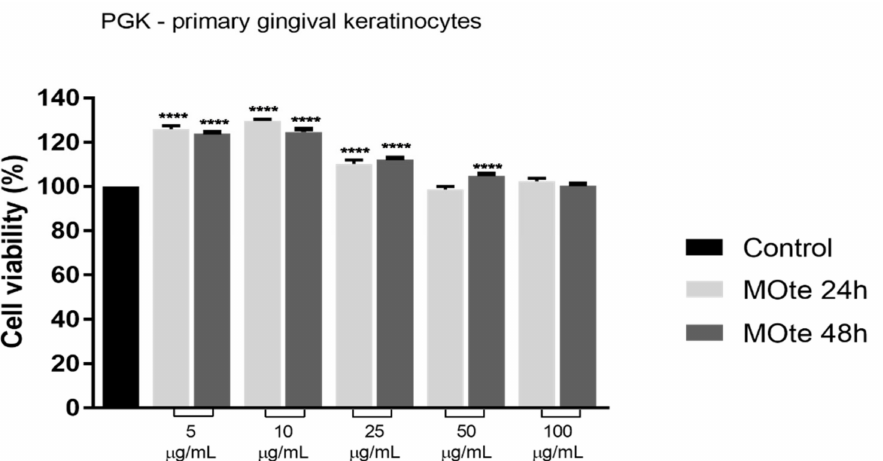
Figure 3. Cell viability assessment of Melissa officinalis total extract (MOte) (5, 10, 25, 50 and 100 µ g/mL) in primary gingival keratinocytes at 24 and 48 h post-stimulation by Alamar blue assay. The results are expressed as cell viability percentage (%) normalized to control (untreated cells). The data represent the mean values ± SD of three independent experiments performed in triplicate. One-way ANOVA analysis was applied to determine the statistical differences in rapport with control cells, followed by Tukey post-test (**** p <